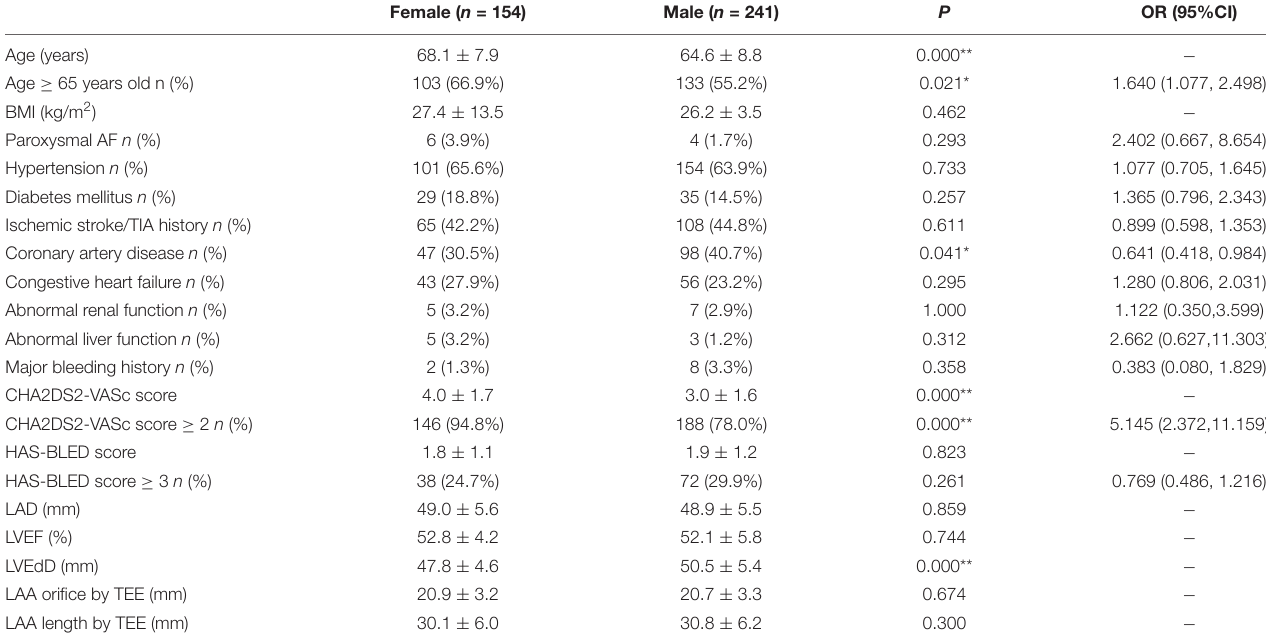
TABLE 1 | Baseline clinical characteristics.